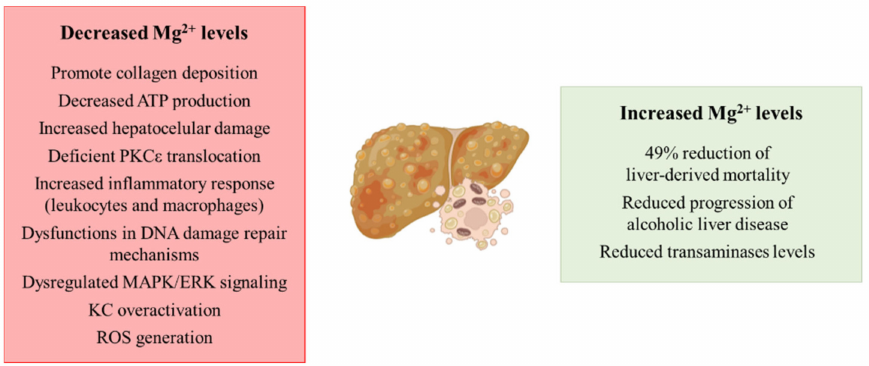
Figure 1. Schematic representation of the contribution of decreased and increased magnesium levels to the development of liver diseases. Abbreviations: PKC ε : protein kinase C ε ; MAPK: mitogen- activated protein kinase; ERK: extracellular signal-related kinase; KC: Kupffer cell; ROS: reactive oxygen